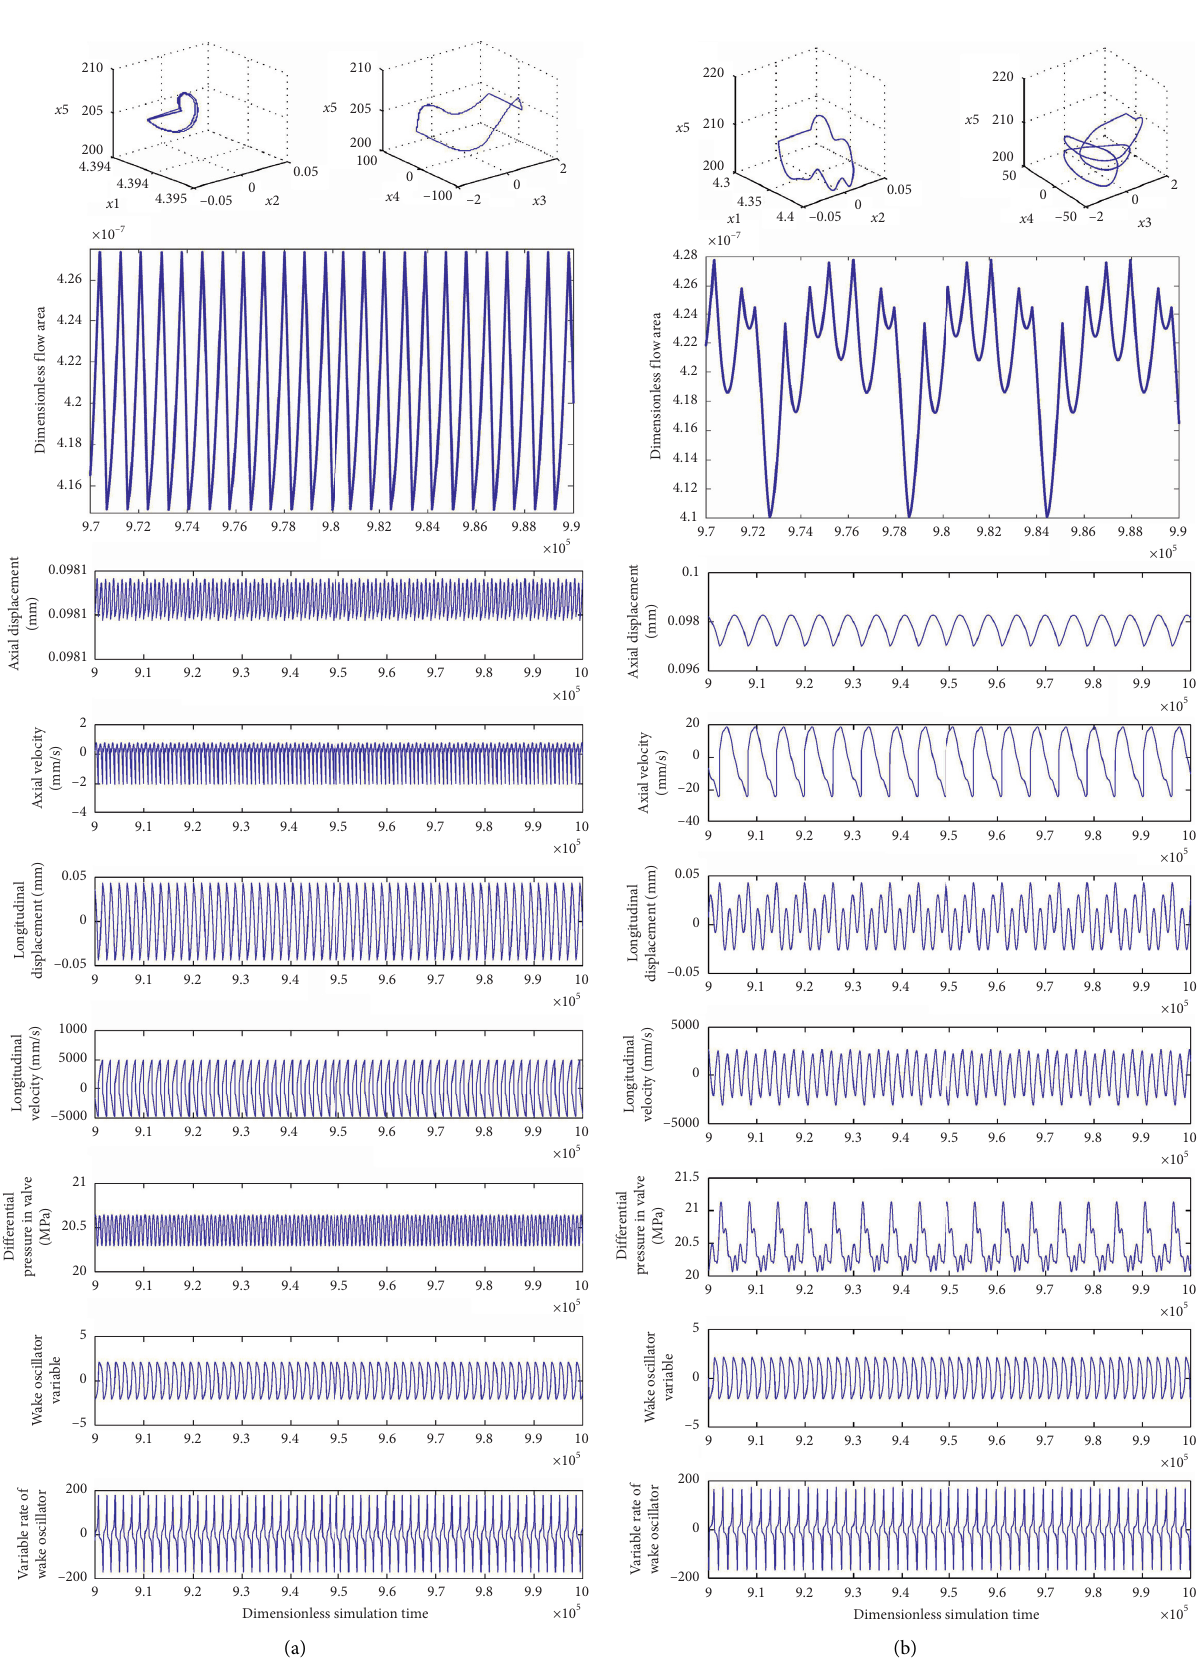
Figure 7: Multistability analysis for the pump inlet pressure of 0.4MPa with the water depth of 66m; (a) simulation results for the first stable condition and (b) that for the second stable